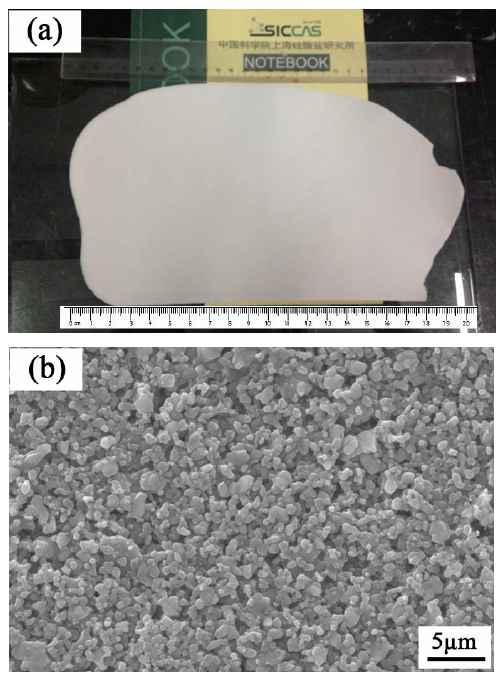
Fig. 6 (a) Photograph and (b) microstructure of AlN green tape after casting in air at room